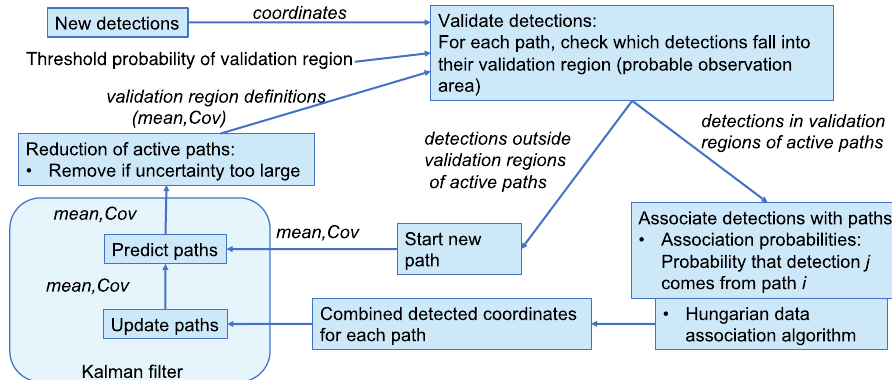
Figure 2: Subtasks of probabilistic reasoning for path